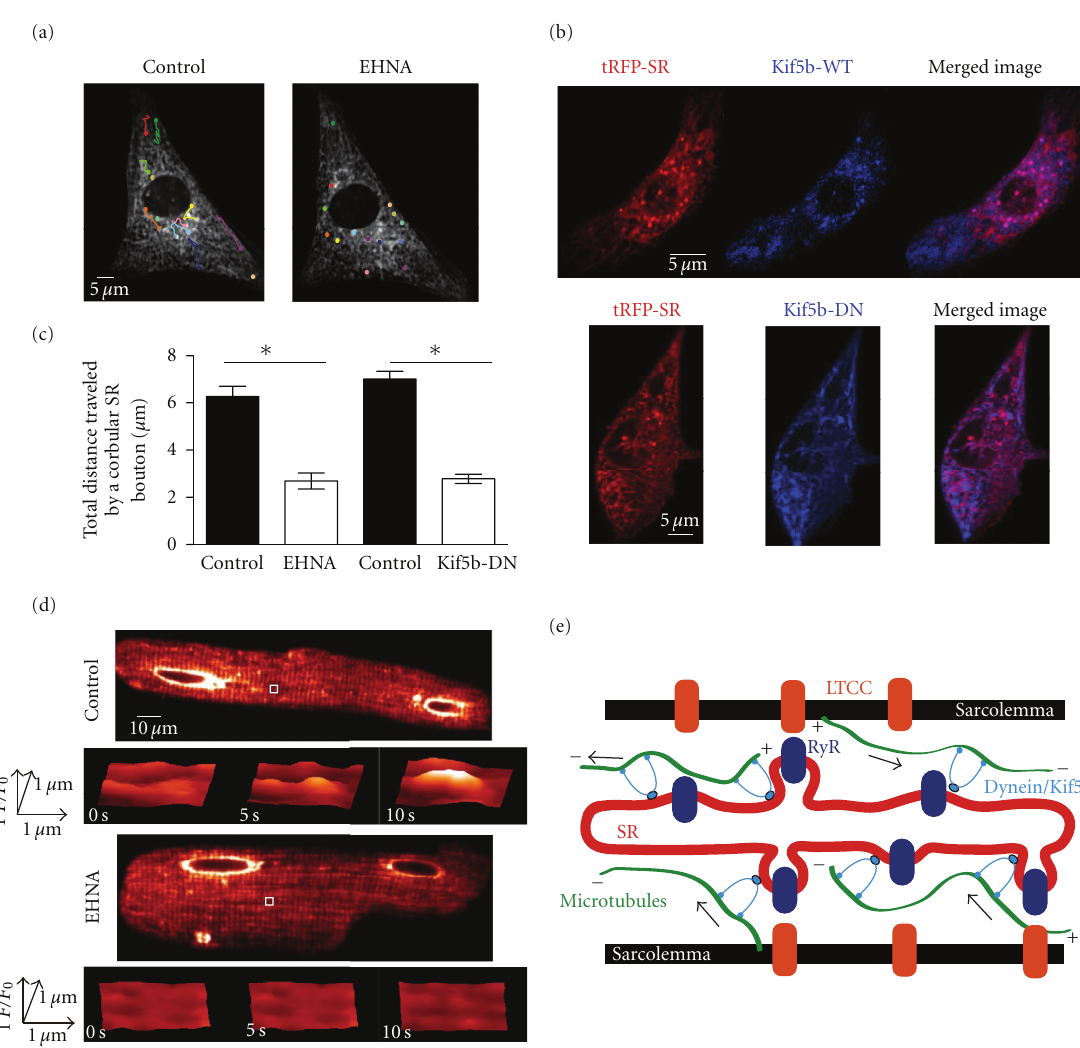
−− Figure 8: The microtubule-associated motors dynein and Kif5b regulate SR motility in ventricular myocytes. (a) Confocal image of neonatal ventricular myocyte expressing tRFP-SR under control conditions and after 120 minutes of 30 μ M EHNA perfusion. Corbular SR boutons are identified with colored circles. (b) Confocal images of neonatal ventricular myocyte expressing tRFP-SR (left) and Kif5b-WT-BFP (top/center) or Kif5b-DN-BFP (bottom/center). The images to the right were generated by merging the tRFP-SR and Kif5b-BFP images. (c) Bar plot of the mean total distance traveled by corbular SR boutons before and after EHNA perfusion and myocytes infected with tRFP-SR (control) and myocytes infected with tRFP-SR and Kif5B-DN-BFP. (d) Confocal images showing tRFP-SR fluorescence of adult ventricular myocytes under control conditions (top) and incubated in the presence of 30 μ M EHNA (bottom). Surface plots show the time- course of fluorescence intensity in the region delineated by the white box. (e) Cartoon depicting a hypothetical model for the regulation of SR structure and motility in ventricular myocytes (LTCC = L-type Ca 2+ channel; RyR = ryanodine